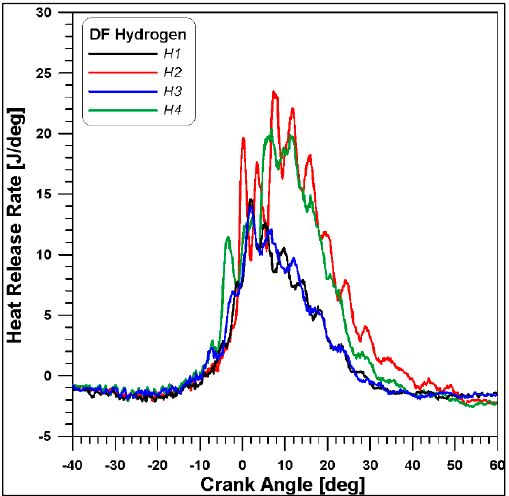
Figure 3. Experimental heat release rate. Cases with methane.